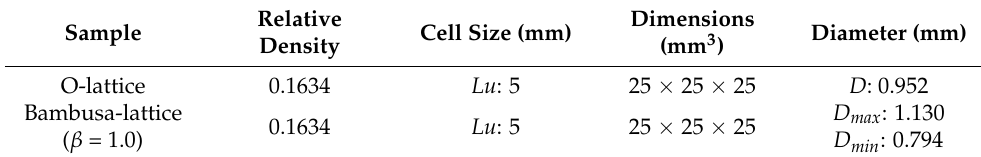
Table 1. Design dimensions of the lattice